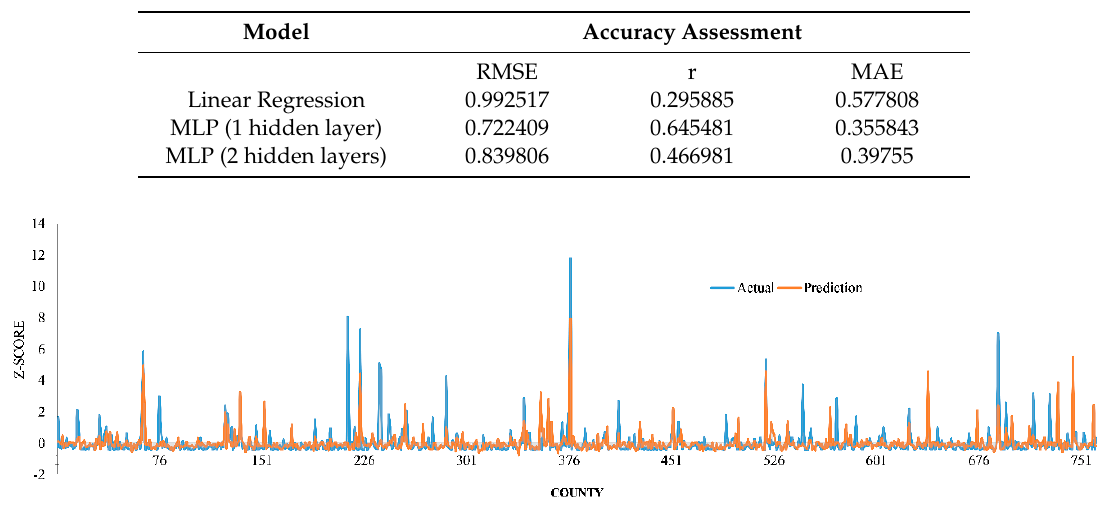
Figure 2. Locations of hotspots of COVID-19 incidence identified by Getis-Ord G i *, continental United States. Table 1. Comparative performance of the employed models (single run) to predict COVID-19 rates across the continental United States.